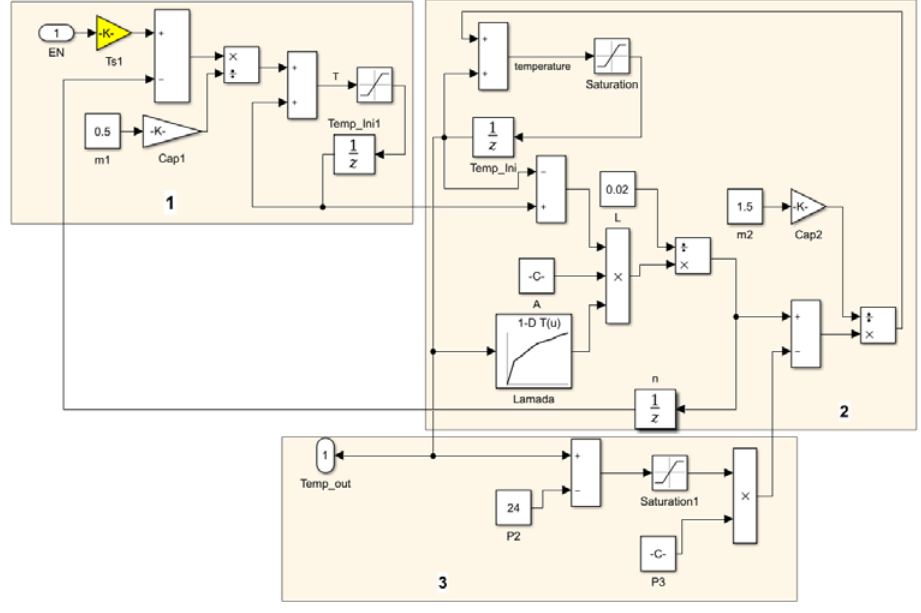
Fig. 4. Electric kettle